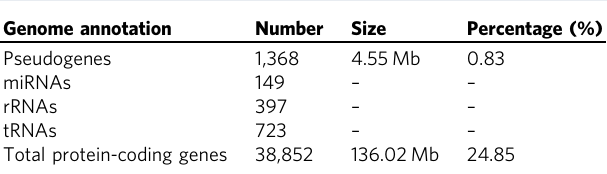
Table 2 Genome annotation statistics of the Chinese wild rice